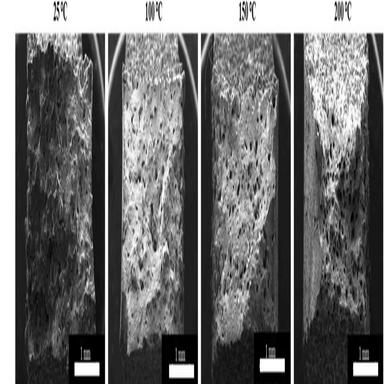
a) Tensile stress-strain curves, b) extracted mechanical properties and c) fractography of the base material tested at various temperatures.